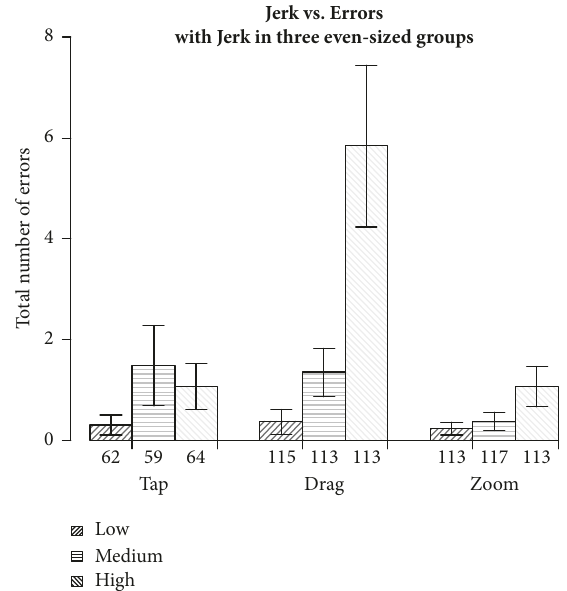
Figure 13: Number of errors per trial for the three task types de- pending on RMS of jerk